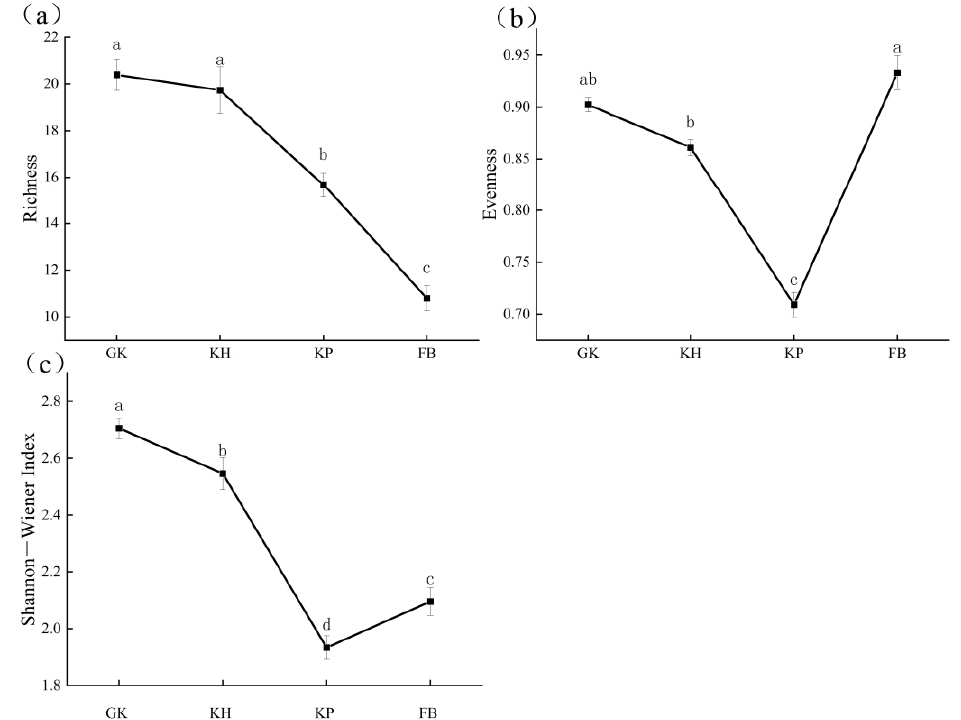
Figure 4. Different biodiversity measures of the multi-stable alpine meadows: ( a ) species richness; ( b ) Pielou evenness; ( c ) Shannon – Wiener index. The error bar represents the standard error. Letters above bars mean a statistical significance was detected using ANOVA and Duncan’s post hoc test (α = 0.05). GK, Gramineae grass – Kobresia humilis community; KH, K. humilis community; KP, K. pygmaea community; FB, Forbs − Black soil.